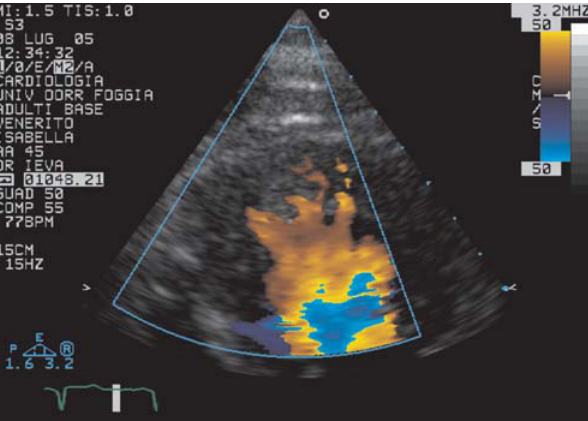
Figure 4 - Details of the systemic ventricle apical segments with prominent trabeculations and color flow imaging. This analysis reveals forward and reverse flow between trabeculae during the cardiac